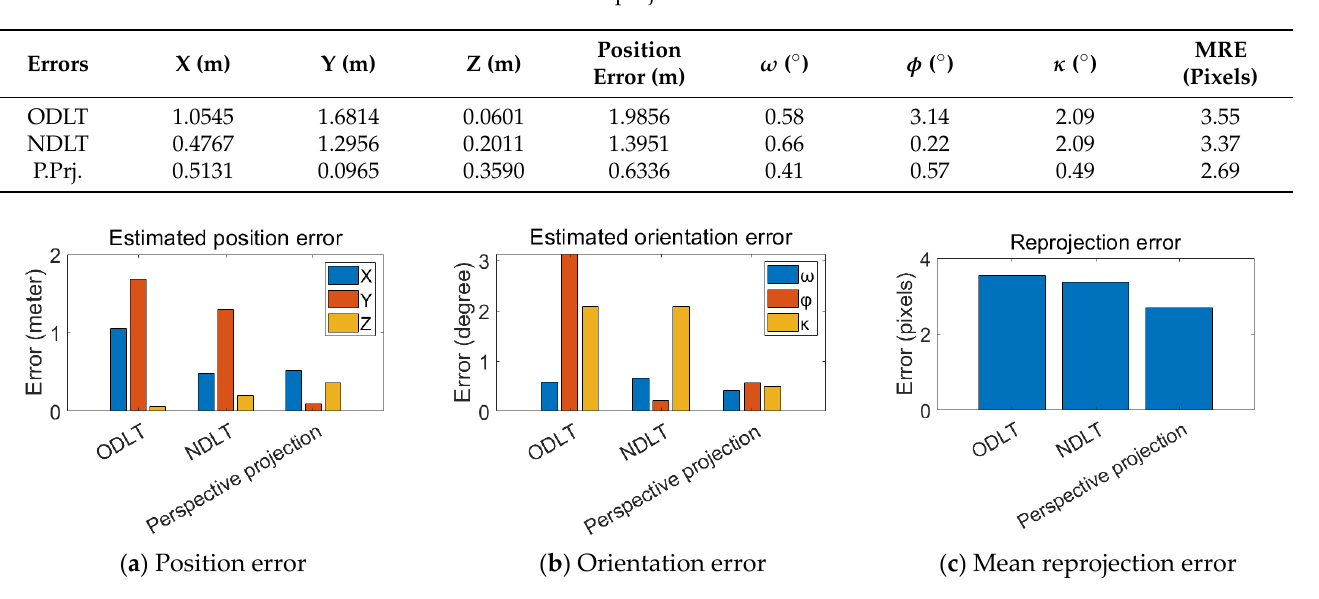
Table 5. Estimated EOP and reprojection errors of CCTV.